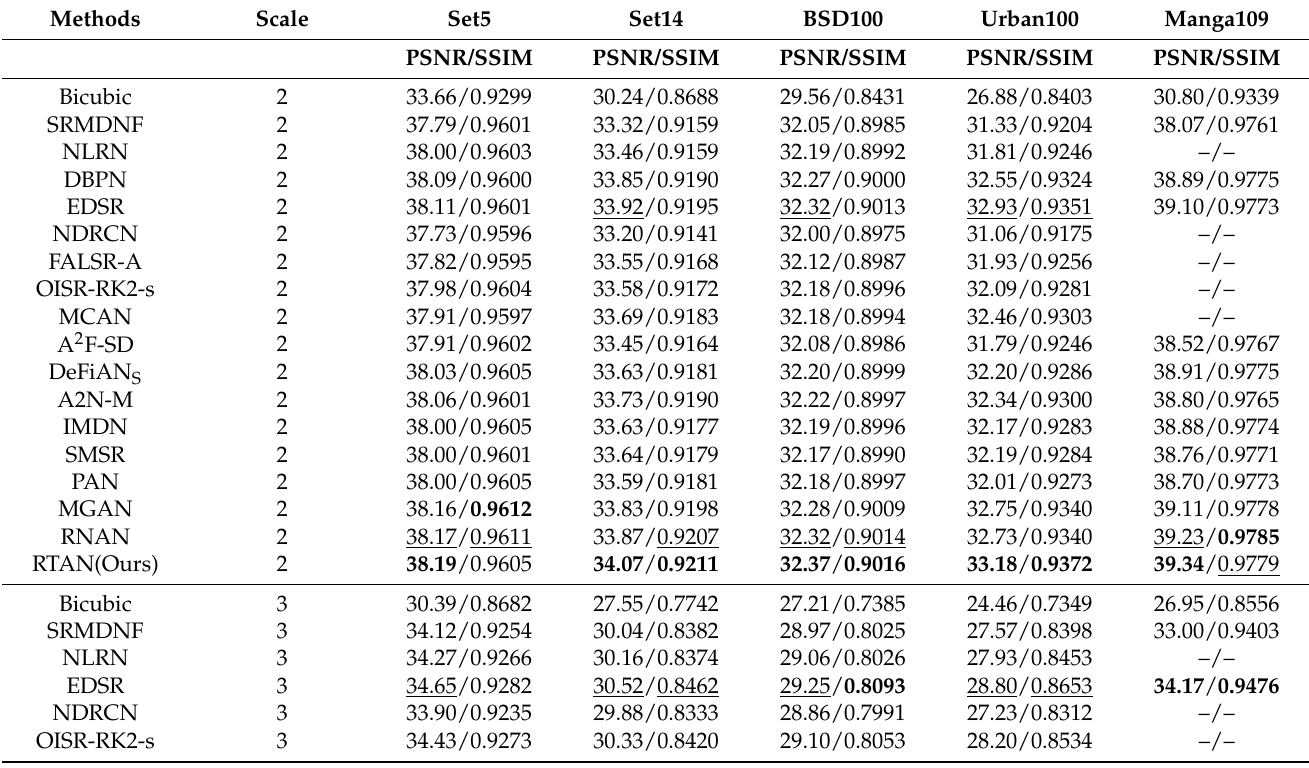
Table 3. The quantitative comparison (i.e., average PSNR/SSIM) with BI degradation model on datasets Set5, Set14, BSD100, Urban100, and Manga109. The best and second-best results are highlighted and underlined, respectively. Methods